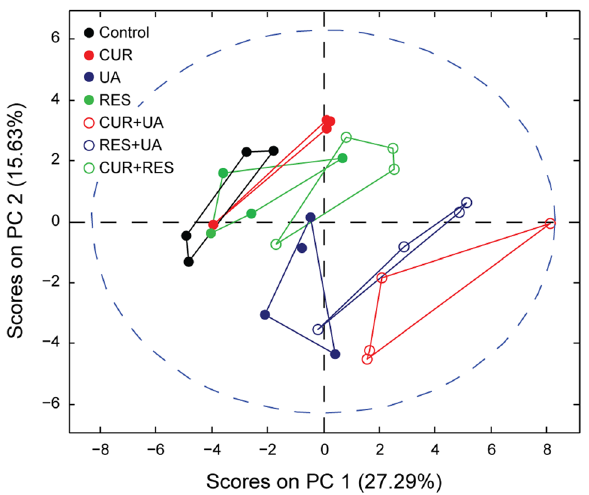
Fig. 4 Treatment-induced metabolic changes in HMVP2 cells. HMVP2 cells were treated with CUR, UA and RES or their combinations of two compounds. The PCA scores plot (PC1 vs. PC2) was obtained from the unsupervised multivariate analysis of the metabolic pro fi le data (polar fraction) acquired using UHPLC-MS and